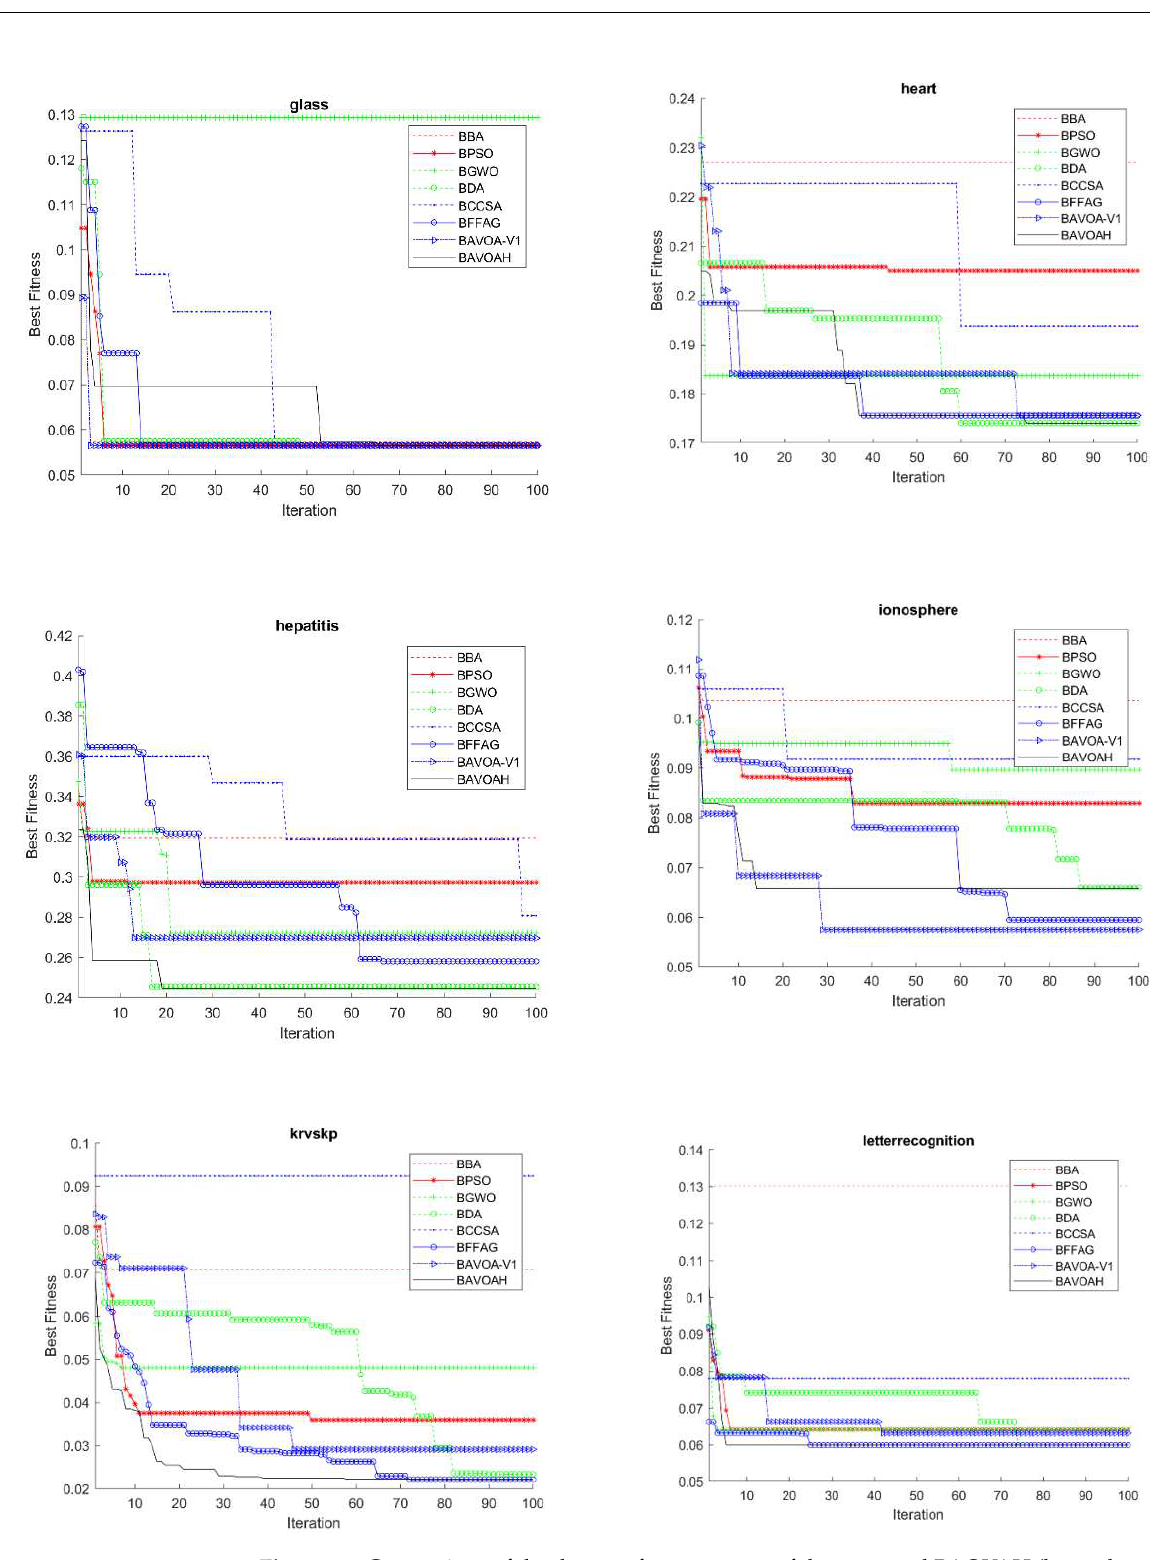
Figure 16. Comparison of the degree of convergence of the proposed BAOVAH (hyper-heuristic) and BAVOA-V1 (multi-strategy) method on the second six data sets.